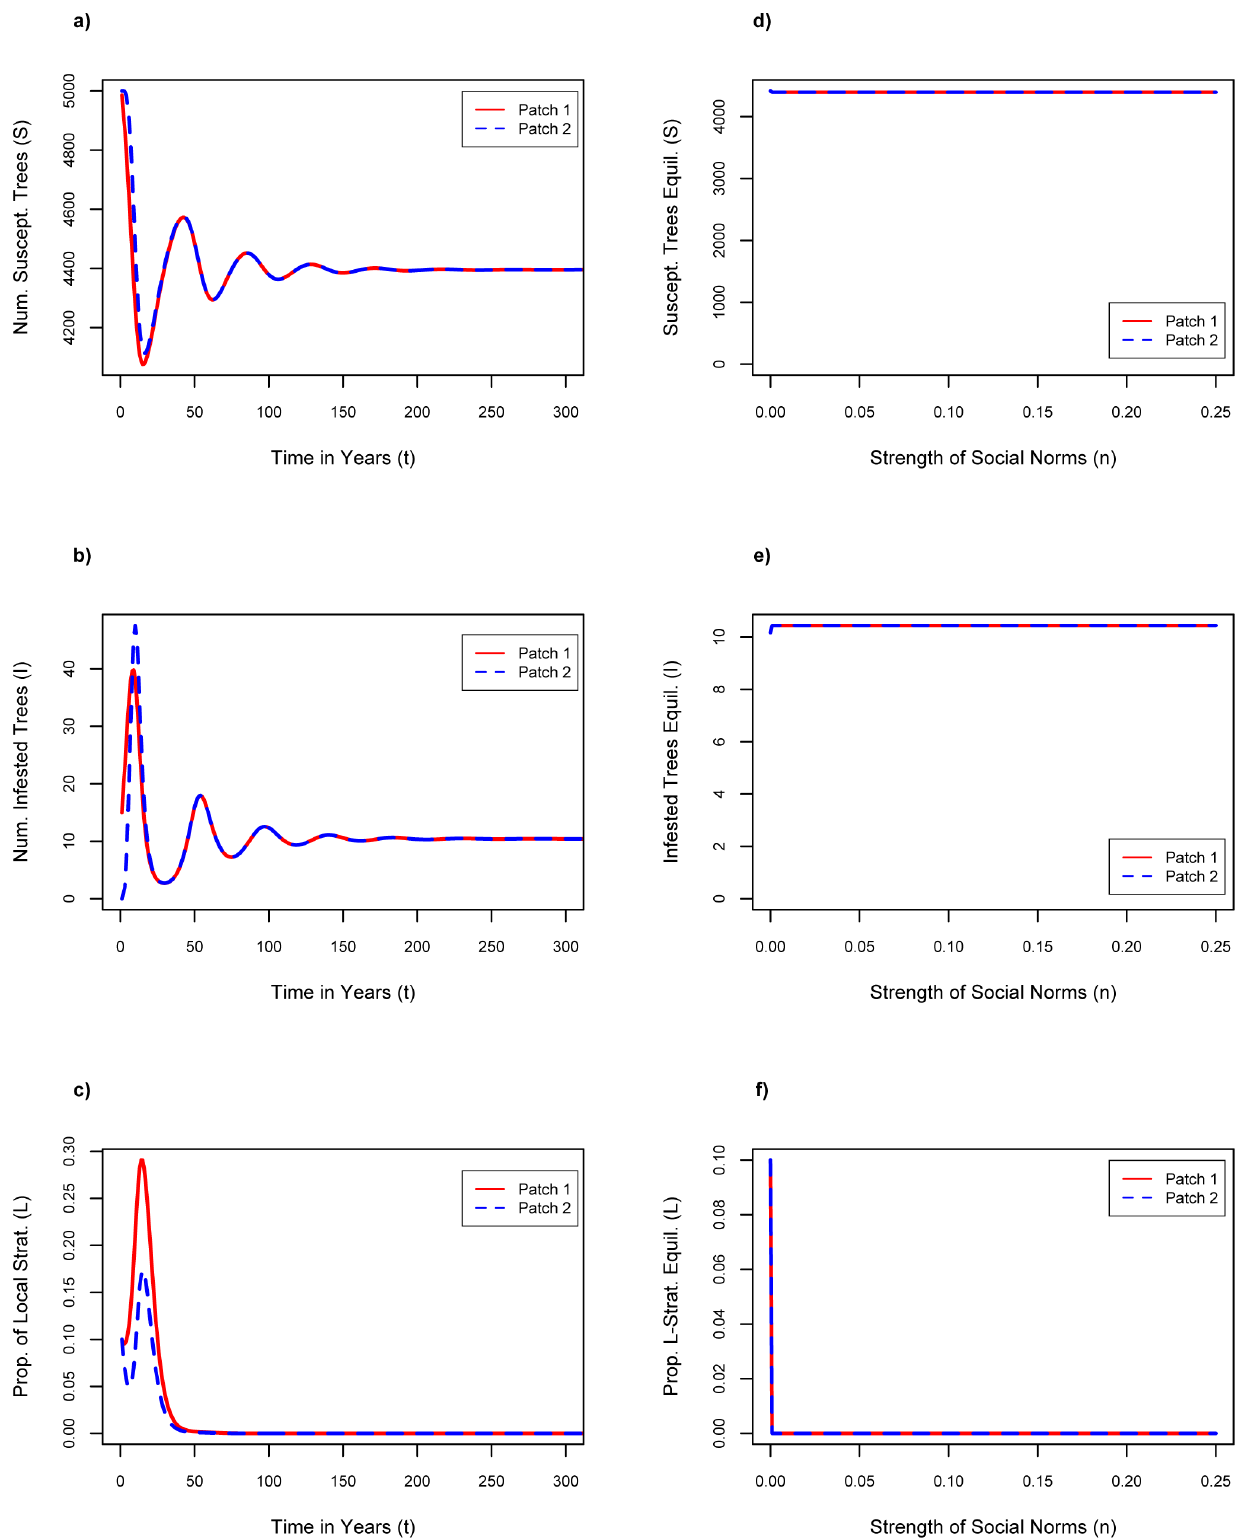
Figure 2. Results of increasing strength of social norms. Increase strength of social norms: f=0.1, s =0.1, Cl= $ 6.75 where a) number of susceptible trees as a function of time with n=0.5; b) number of infested trees as a function of time with n=0.5; c) proportion of local firewood strategists as a function of time with n=0.5; d) susceptible tree equilibria for increasing values of n; e) infested tree equilibria for increasing values of n; f) proportion of local firewood strategist equilibria for increasing values of n.